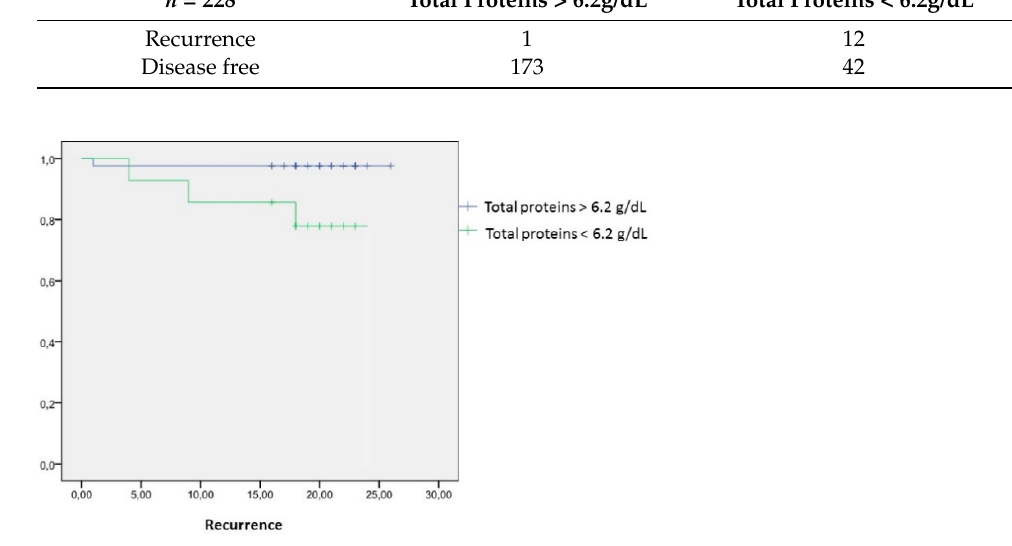
Figure 1. Kaplan–Meier curve between preoperative total protein levels and recurrence after 24 months of follow-up.